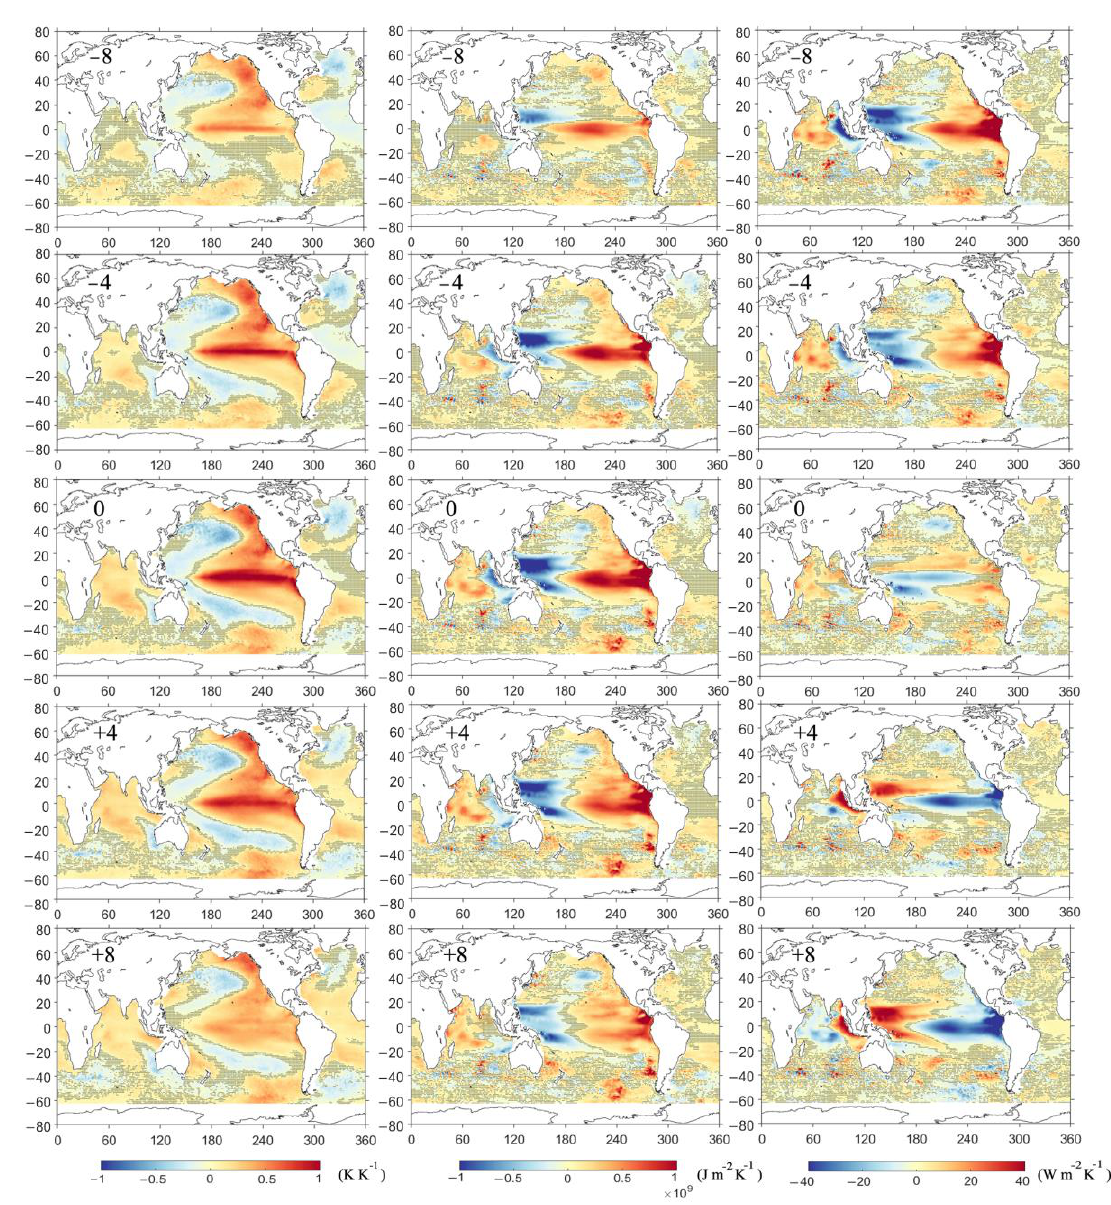
Figure 10. The lagged or leading correlation maps of SST (left), OHC (middle), and OHU (right) onto the ONI from the OPEN dataset. Different lags are −8, −4, 0, +4, and +8 months ( a positive value means after El Niño). The stipples indicate insignificant signals (95% confidence level).